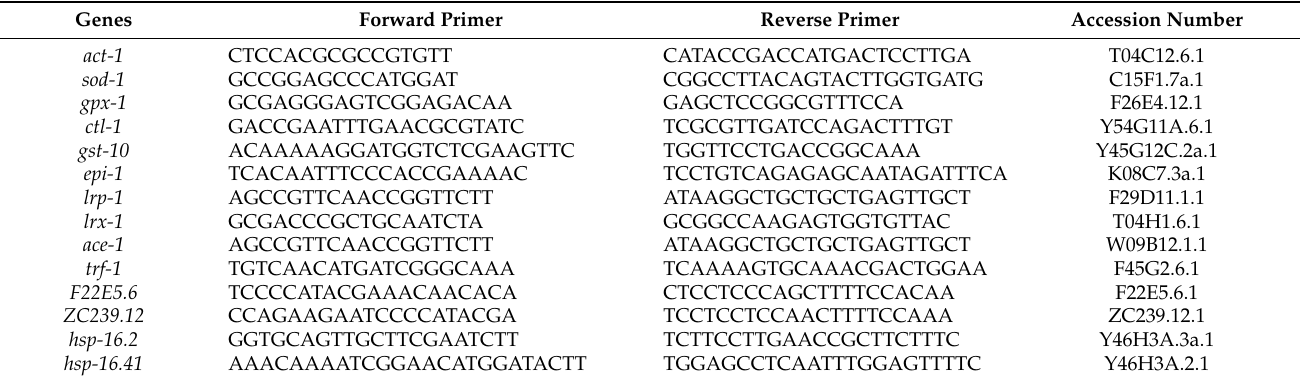
Table 3. Oligonucleotide primers used in RT-qPCR